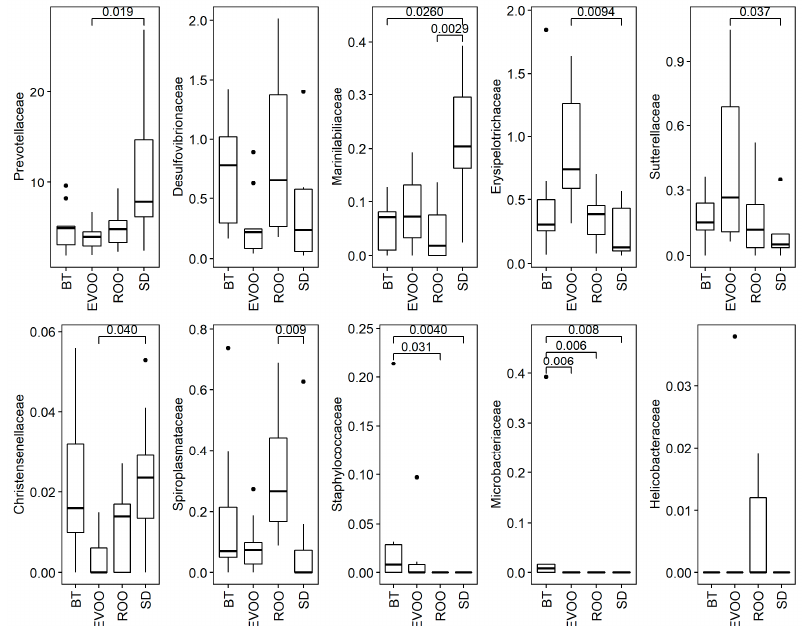
Figure 3. Box plots of presence of the ten families with significant differences ( p < 0.05), in percentage of sequences, after feces DNA extraction from mice fed with the different diets. BT: butter diet; EVOO: extra virgin olive oil diet; ROO: refined olive oil diet; SD: standard chow. SD, EVOO and BT diet values from [12]. Significant pairwise comparisons adjusted p -values are also shown.